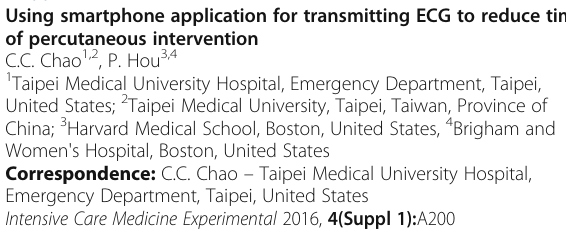
Fig. 87 (abstract A199). Timecourse of haemodynamic, contractility and perfusion markers in mild (IA/LV < 19 %, green dots) and severe (IA/LV > 19 %, blue dots) animals. Ischaemia time shown as red area